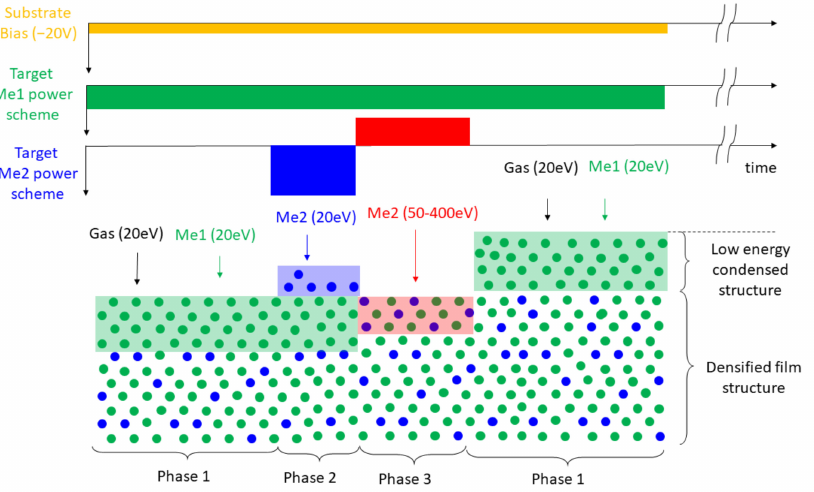
Figure 1. Schematics of the film growth process consisting in three different phases which are intentionally separated in the time